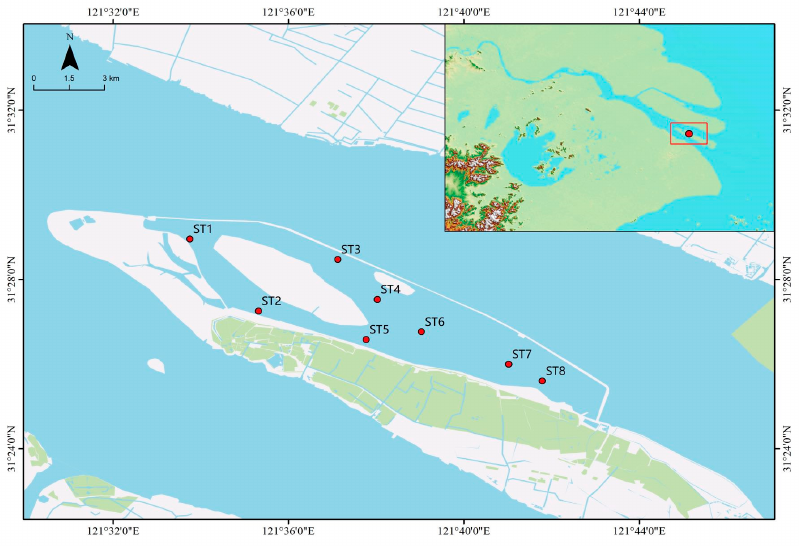
Figure 1. Distribution map of the reservoir sampling stations.